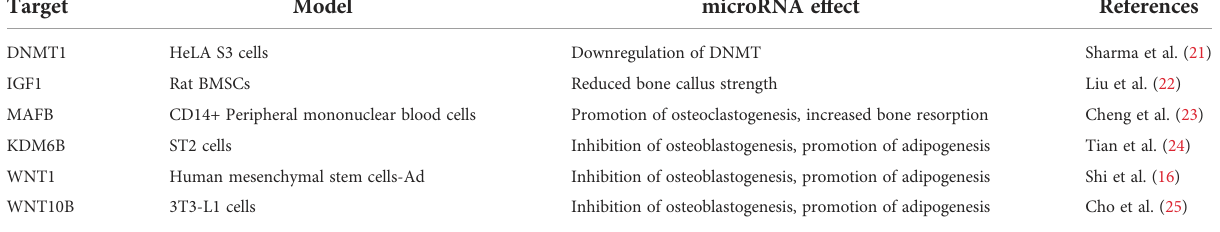
TABLE 4 Bone and fat metabolism related validated targets of miR-148-3p.